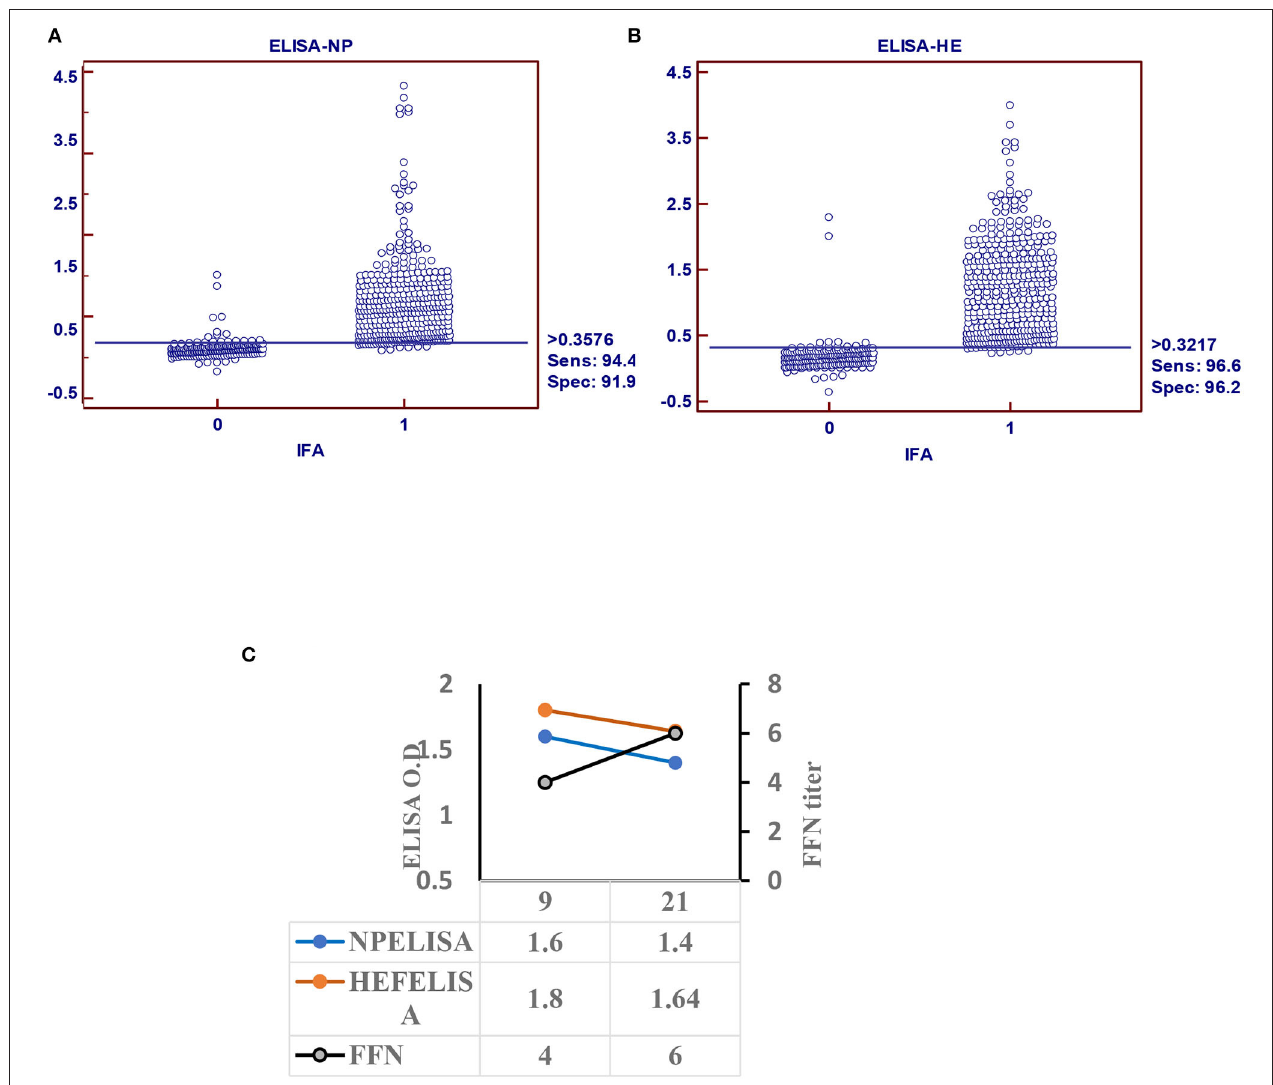
FIGURE 2 | Indirect ELISA specific for IDV (iELISA). (A) Receiver operator characteristics (ROC) and diagnostic sensitivity and specificity of IDV-NP. (B) ROC analysis and diagnostic sensitivity and specificity of IDV-HE (MedCalc version 11.1.1.0, MedCalc software, Mariakerke, Belgium) In each panel, dot plot on the left and right denote negative and positive testing populations, respectively. The horizontal line bisecting the dot plots denotes the cutoff value for optimal diagnostic sensitivity and specificity. (C) Seroconversion of IDV in infected calves using ELISA-based NP, HE, and FFN in calves experimentally infected with IDV.